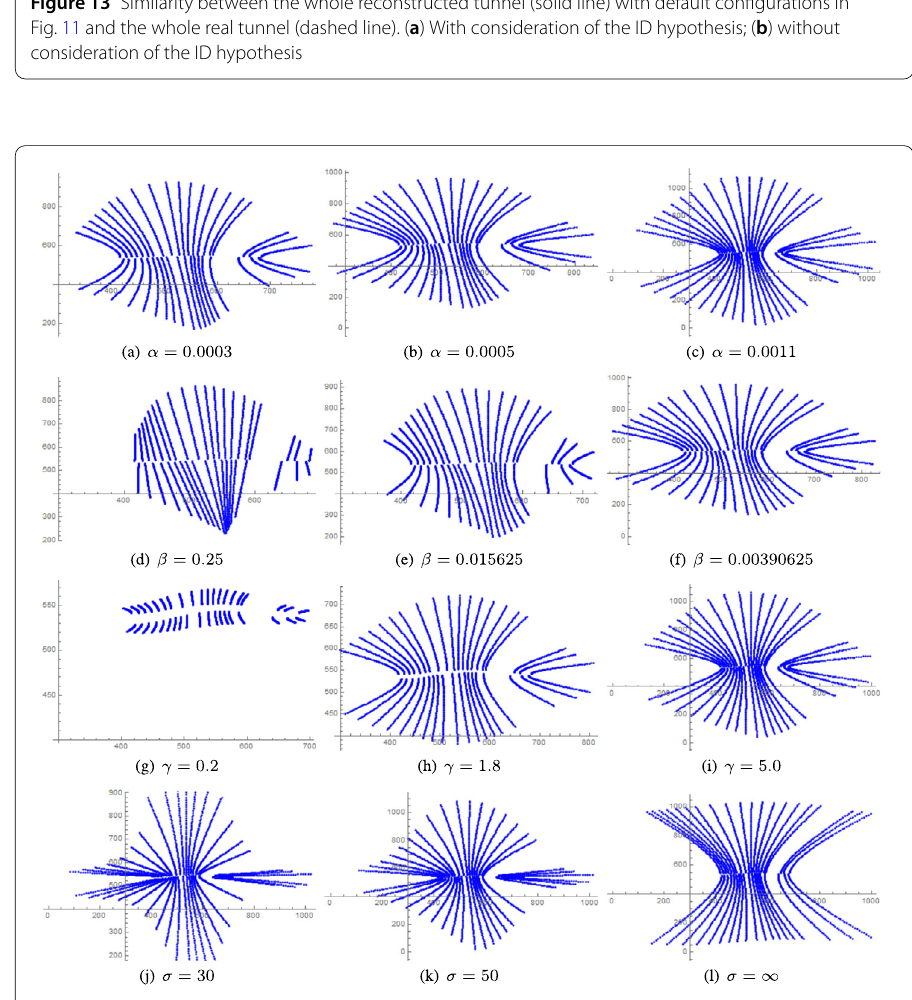
Figure 14 Reconstructed tunnel maps for different parameters. The default configurations of α , β , γ , σ